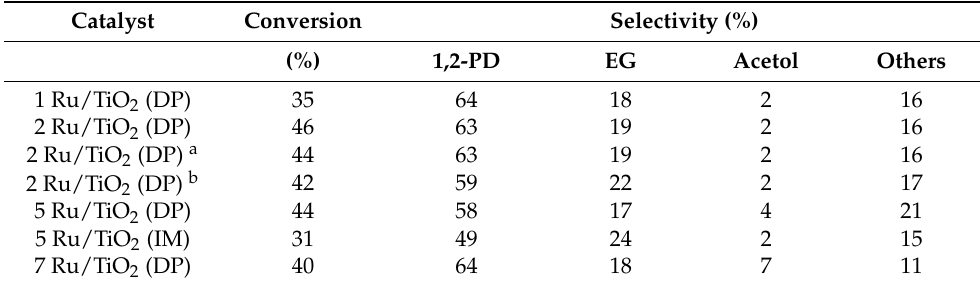
Table 6. Hydrogenolysis of